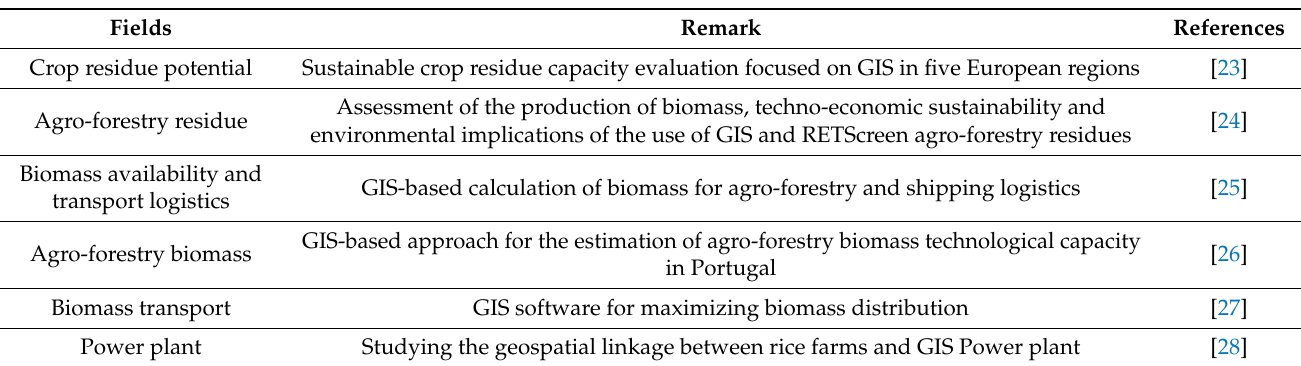
Table 1. GIS implementations in